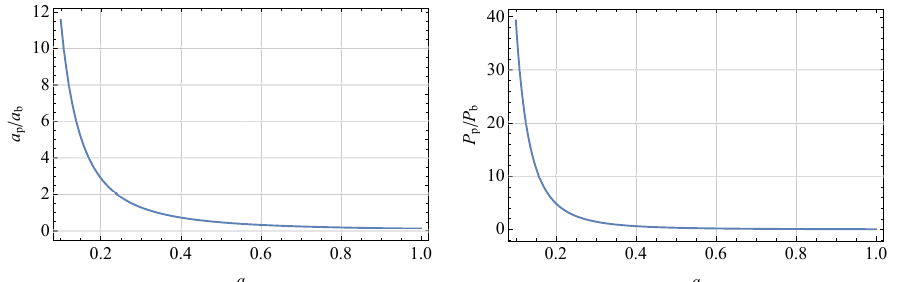
Figure 1. Left panel: ratio of the planet’s semimajor axis a p to the inner binary’s one a b as a function of q according to Equation (12). Right panel: same for the orbital periods of the planet ( P p ) and of the inner binary ( P b